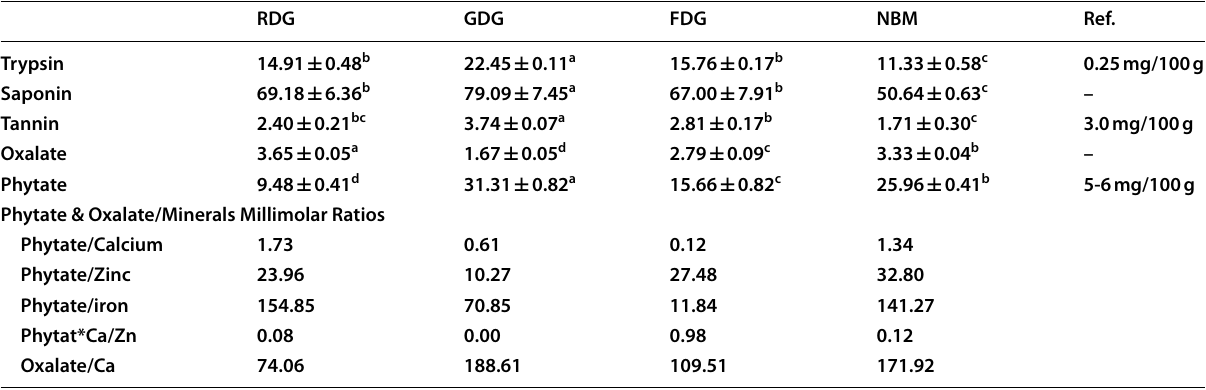
RDG Raw maize, defatted groundnut and ginger in ratio 76.7:20.8:2.5 GDG Germinated maize, defatted groundnut and ginger in ratio 74.4:23.1:2.5 FDG Fermented maize, defatted groundnut and ginger in ratio 72.6:24.9:2.5 NBM Nutribom (a commercial maize-based complementary food) a, b, c, d Means ( SEM) with different alphabetical superscripts in the same row are significantly different at P < ±